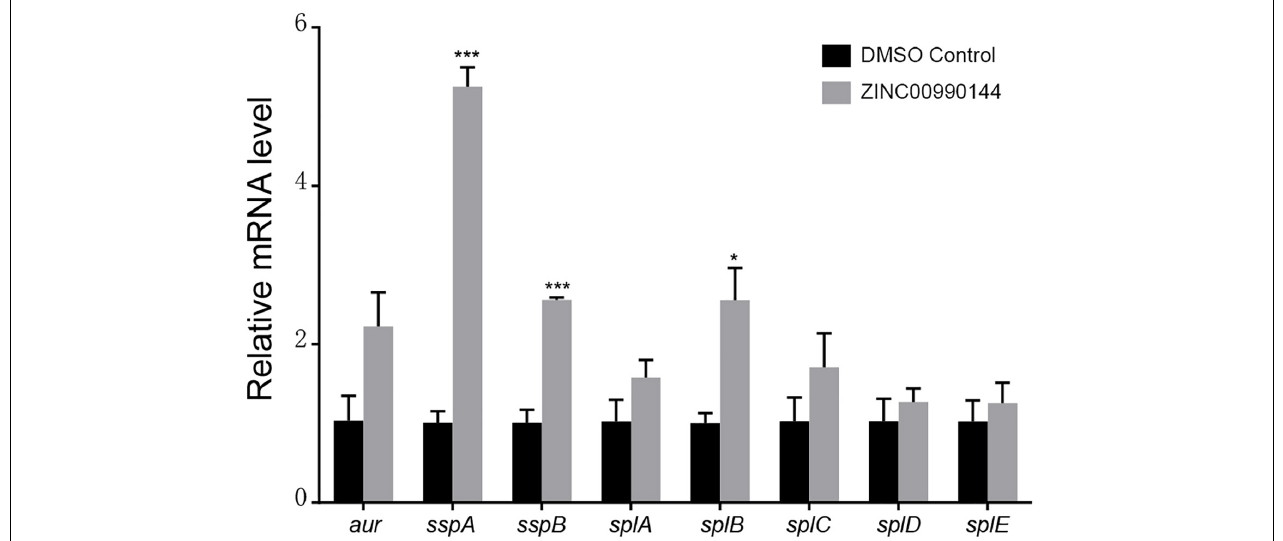
FIGURE 4 | Transcriptional changes of selected biofilm-associated genes after ZINC00990144 treatment. Following ZINC00990144 treatment, transcription levels of aur , sspA , sspB , splA , splB , splC , splD , and splE were investigated by qPCR in strain USA300. Each group contains three independent replicates. The fold change was in relative to the untreated samples. * P < 0.05, *** P < 0.001 comparing with DMSO control.